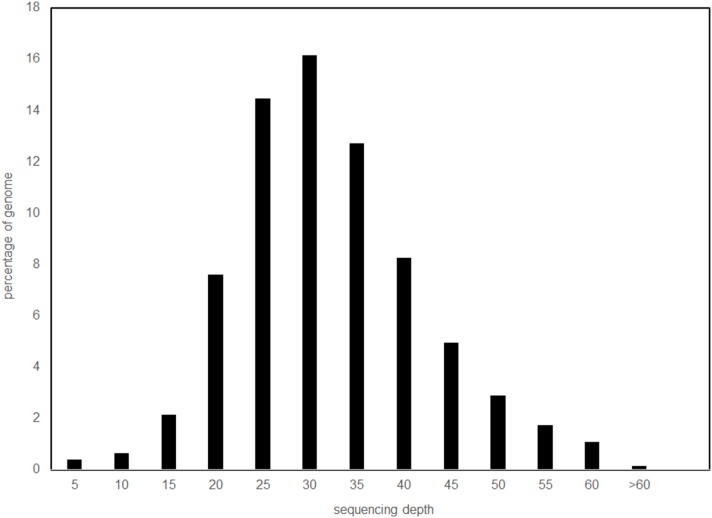
Depth of sequencing of the A. chrysaetos genome.Sequencing depth is on the x-axis while the y-axis shows the percentage of total bases at a given depth. Reads were aligned to the genome using bowtie2.